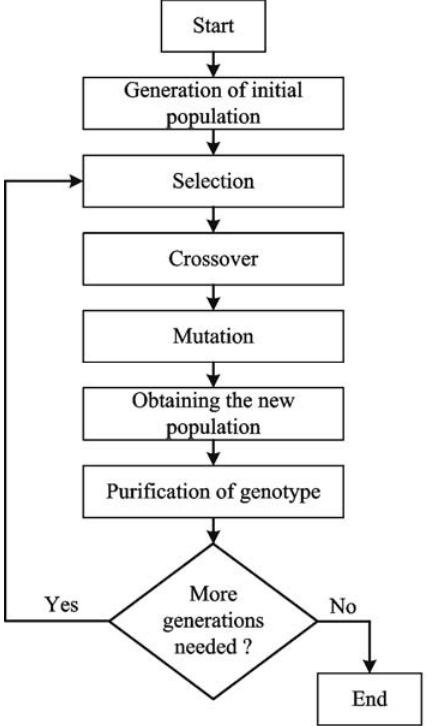
Fig. 11. Modified genetic